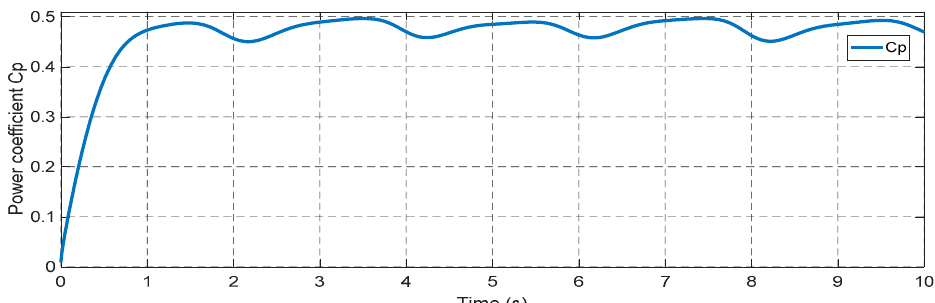
Figure 14. Coefficient power.